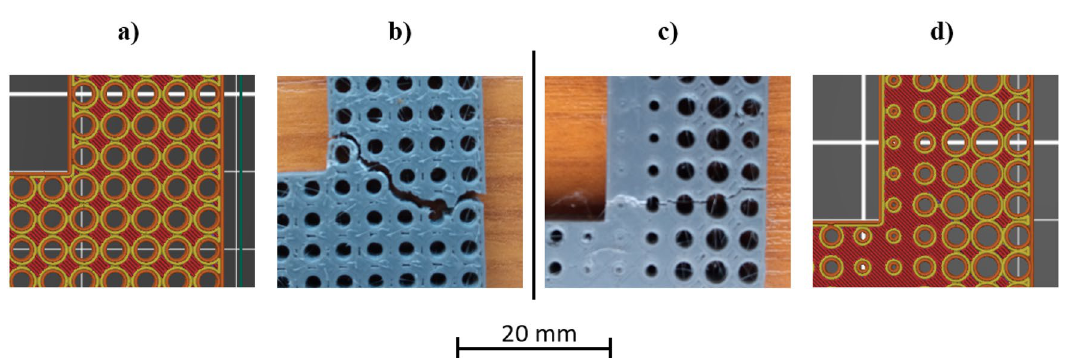
Figure 6. Peculiarity of FDM technology ( a ) generated toolpath for 4 × 4 unscaled specimen, ( b ) broken region of 4 × 4 unscaled specimen, ( c ) broken region of 4 × 4 scaled specimen, and ( d ) generated toolpath for 4 × 4 scaled